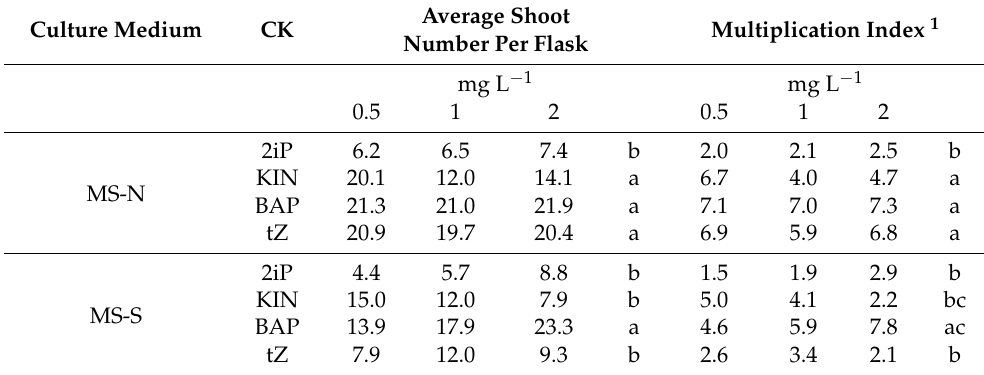
Table 1. Effect of the type of CK and culture media on shoot